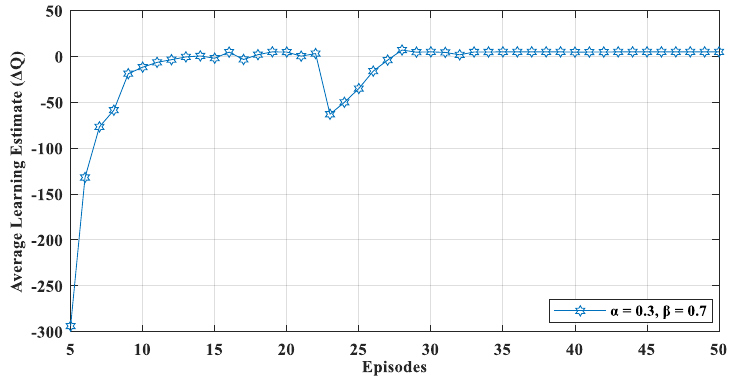
Figure 6. Convergence of learning estimate 𝛥𝑄 in a dynamic network environment (adding new nodes in the network during simulation).